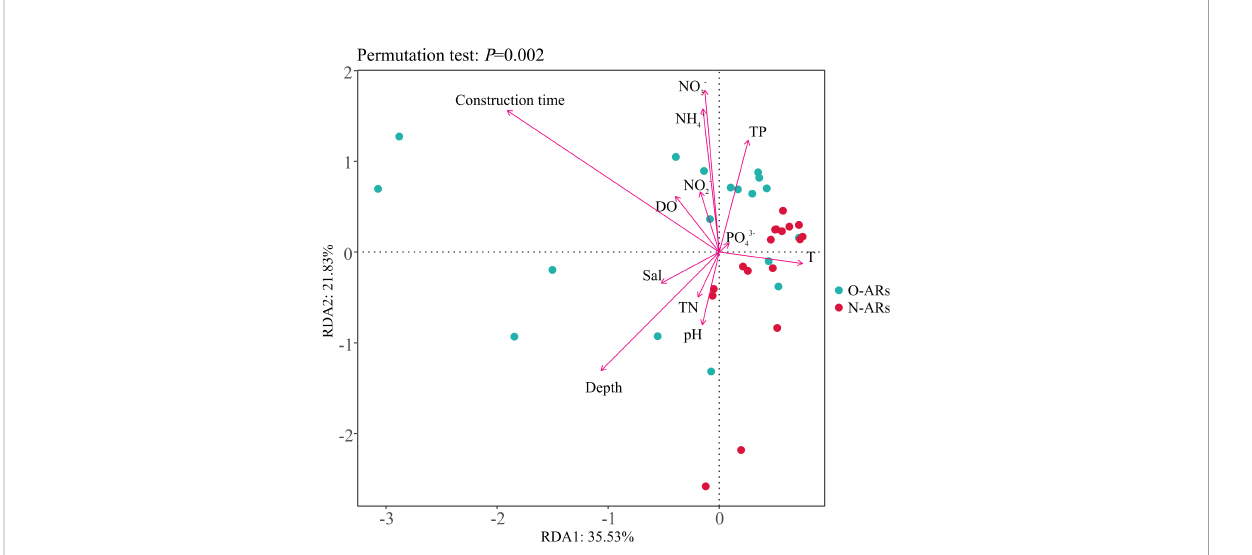
FIGURE 4 Redundancy analysis (RDA) based on the Bray-Curtis dissimilarity. Dots represent samples; different colours represent the ARs with different construction times; arrows represent environmental factors; the angles between environmental factors represent positive and negative correlations between environmental factors (acute angle: positive correlation; obtuse angle: negative correlation; right angle: no correlation); and the closer the projection points and arrows are, the closer the relationship between the sample and the environmental factor is.